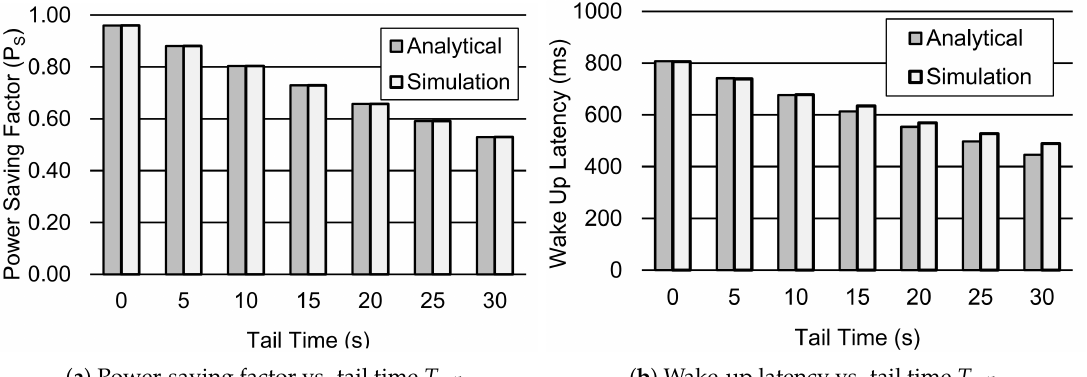
Figure 8. Performance analysis of the DRX mechanism for different values T tail . Other parameter settings include 1